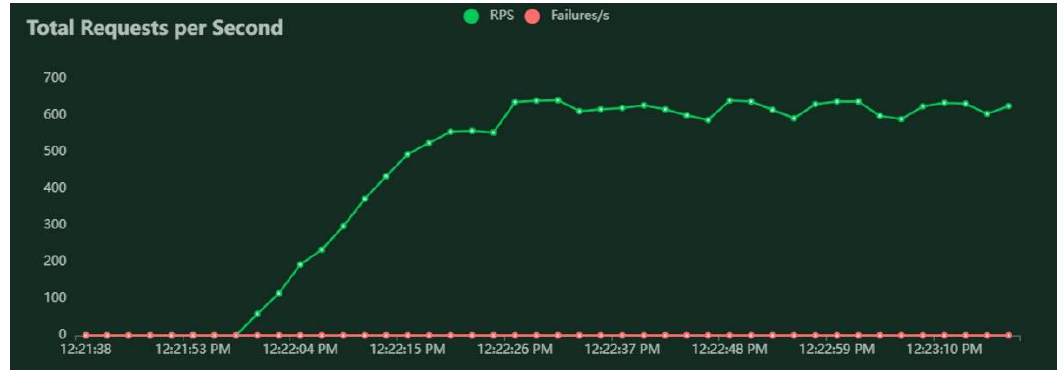
Figure 5. Response time for 1000 VUs and 0-policy.